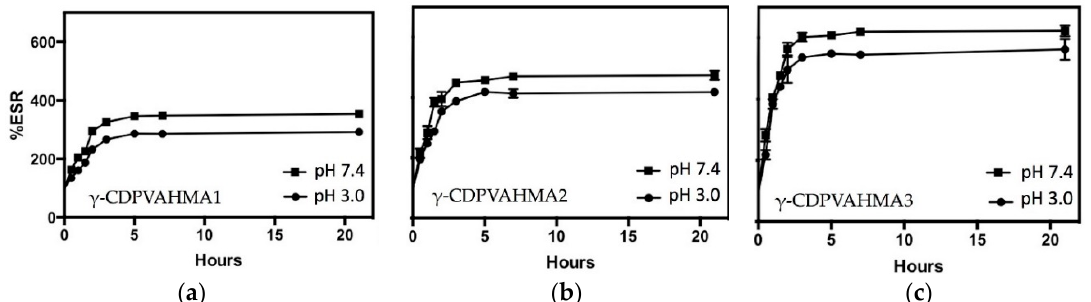
Figure 5. Dependence of the %ESR of γ -CDPVAHMA hydrogels on the amount of γ -CD and pH: ( a ) %ESR of γ -CDPVAHMA1 at pH 3.0 and pH 7.4; ( b ) %ESR of γ -CDPVAHMA1 at pH 3.0 and pH 7.4; and ( c ) %ESR of γ -CDPVAHMA1 at pH 3.0 and pH 7.4.